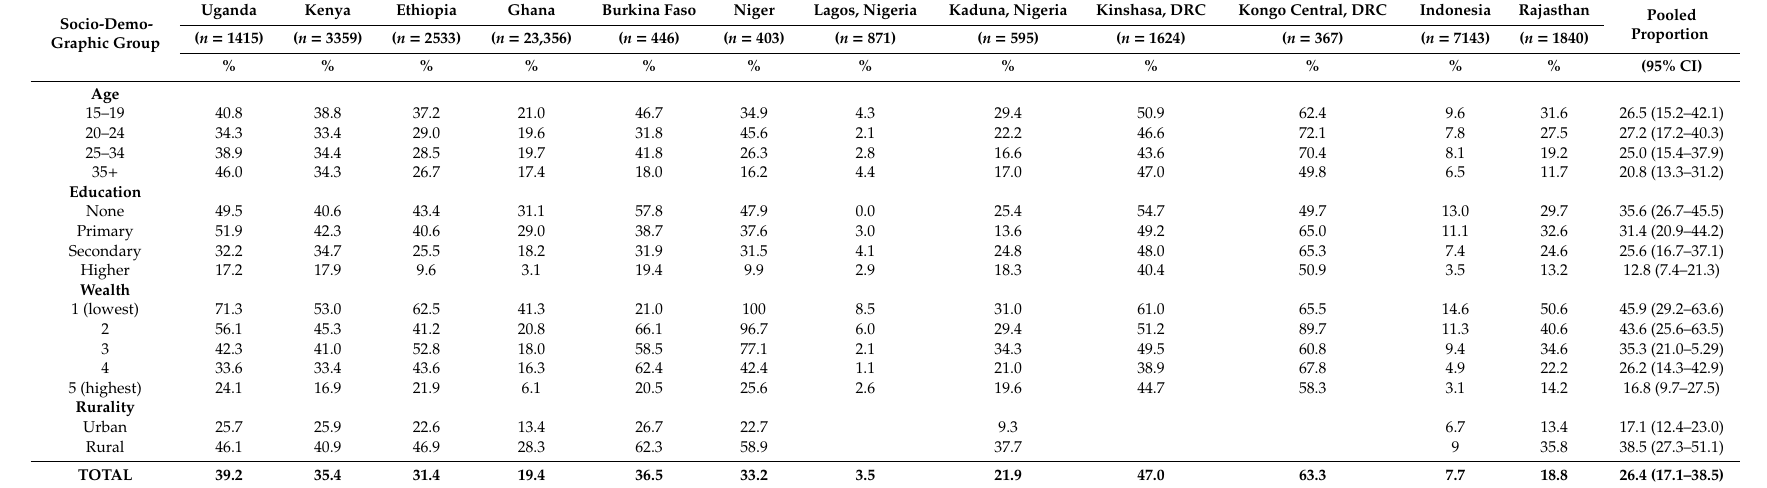
Table 3. Misrepresentation of menstrual needs as being met among exclusive menstrual pad users (single-response variable), by socio-demographic characteristics. Socio-Demo- Graphic